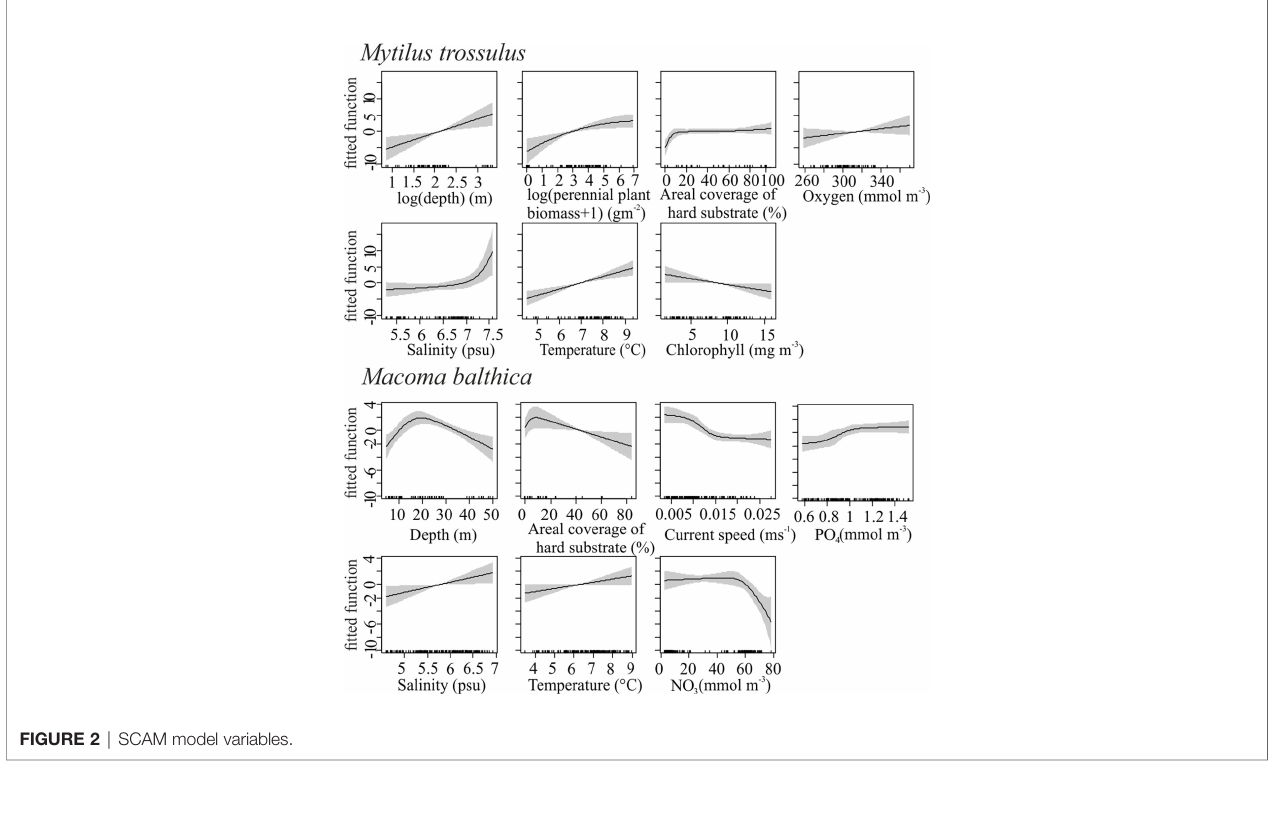
FIGURE 2 | SCAM model variables.